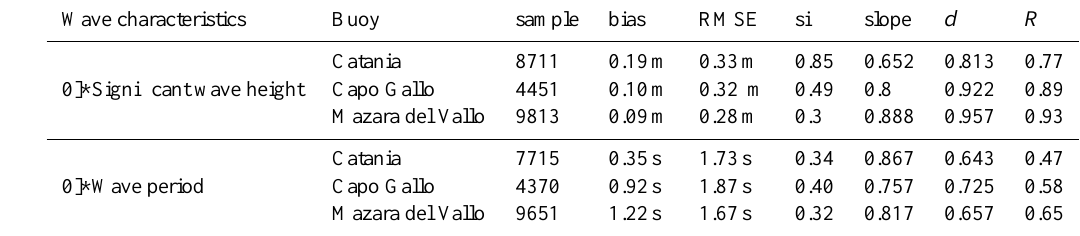
Table 1. Performance indices of the ECMWF data: comparison between ECMWF data and buoy data. Wave characteristics